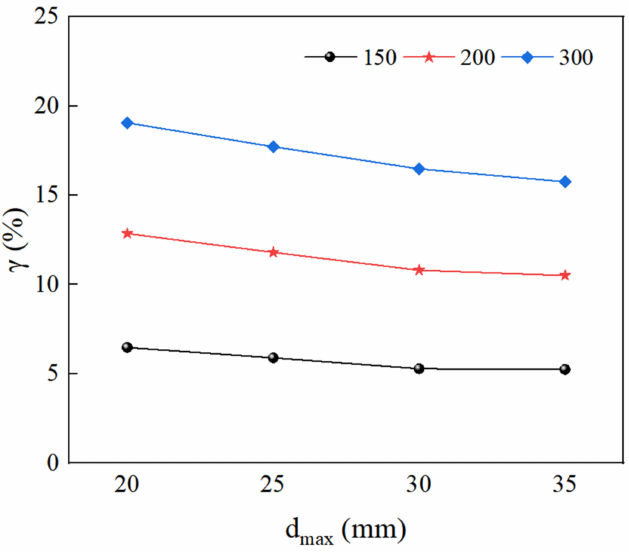
Figure 22. The size effect degree of RAC under different maximum aggregate